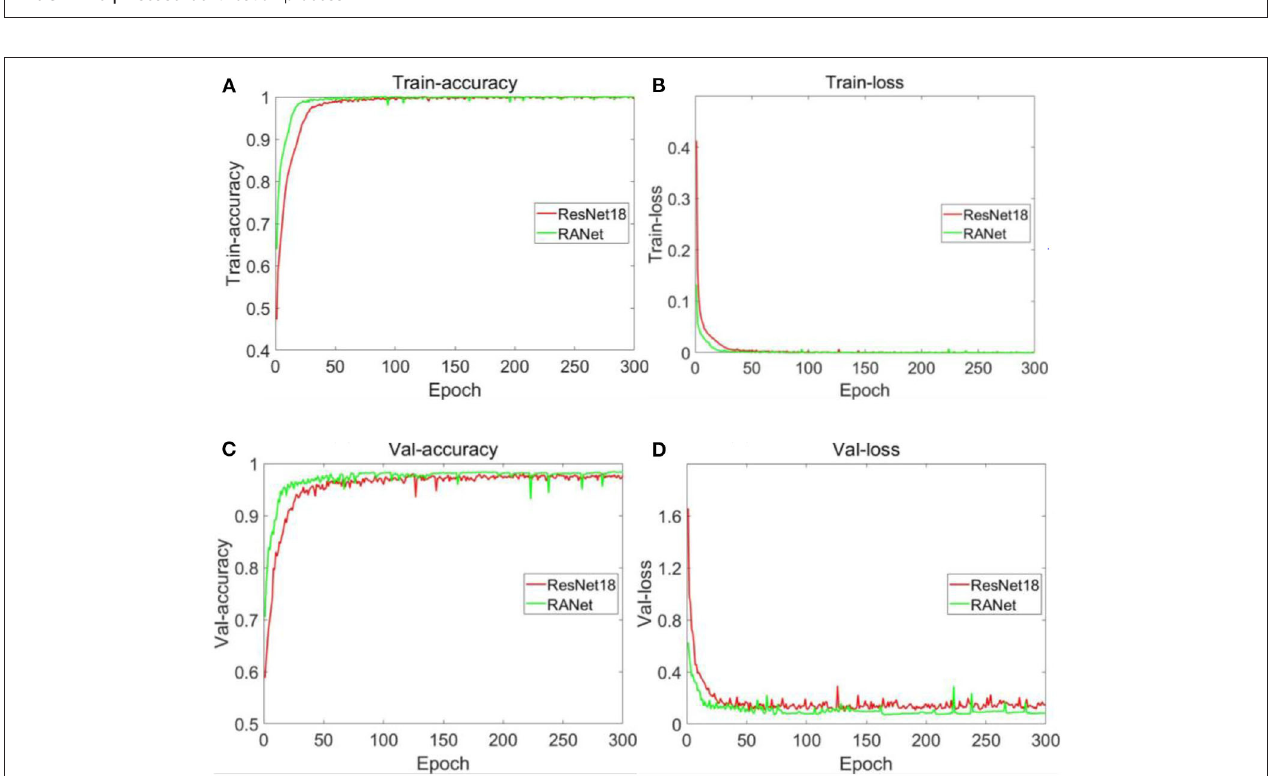
FIGURE 17 | Changes in accuracy and loss values of training sets and validation sets of different models. (A) Accuracy of training set. (B) Loss value of training set. (C) Accuracy of validation set. (D) Loss value of validation